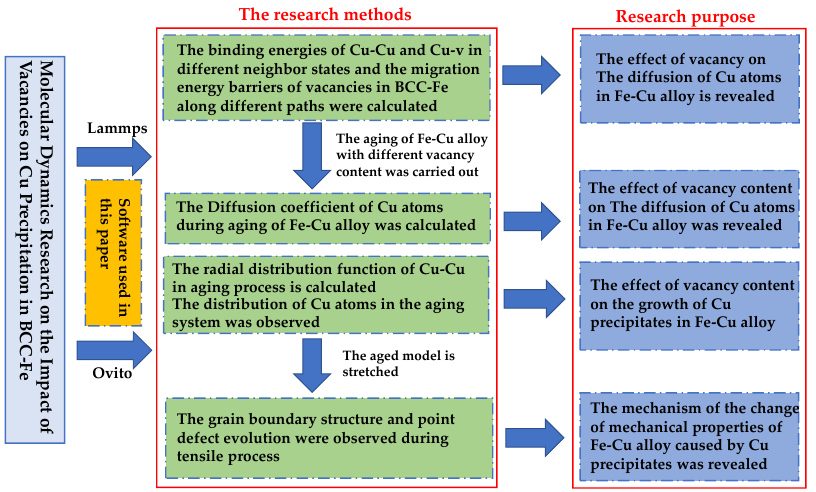
Figure 1. The technology roadmap.